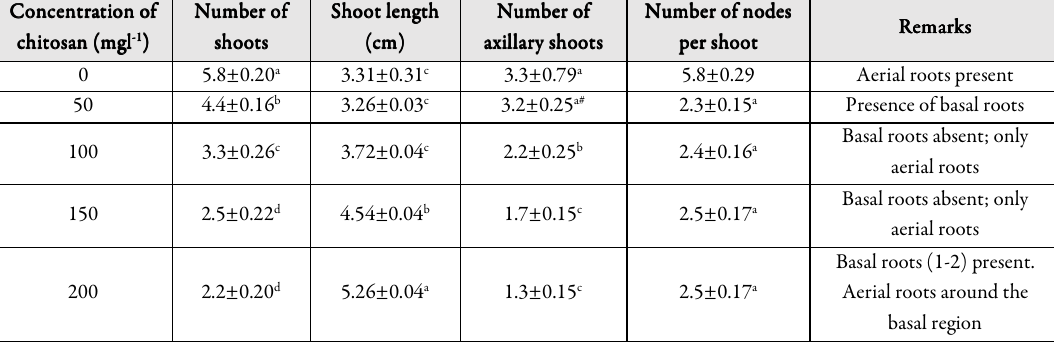
Values represents mean±SE of 10 replicates repeated thrice. Mean values followed by the same letter in a column do not differ significantly based on ANOVA and Duncan’s multiple range test at p≤